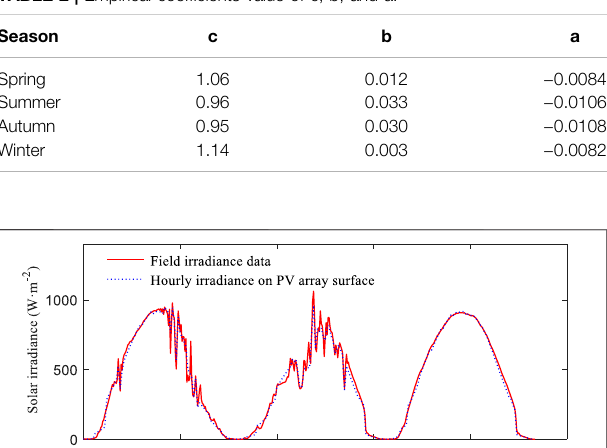
TABLE 3 | Equipment con fi guration parameters of the DKASC PV system.